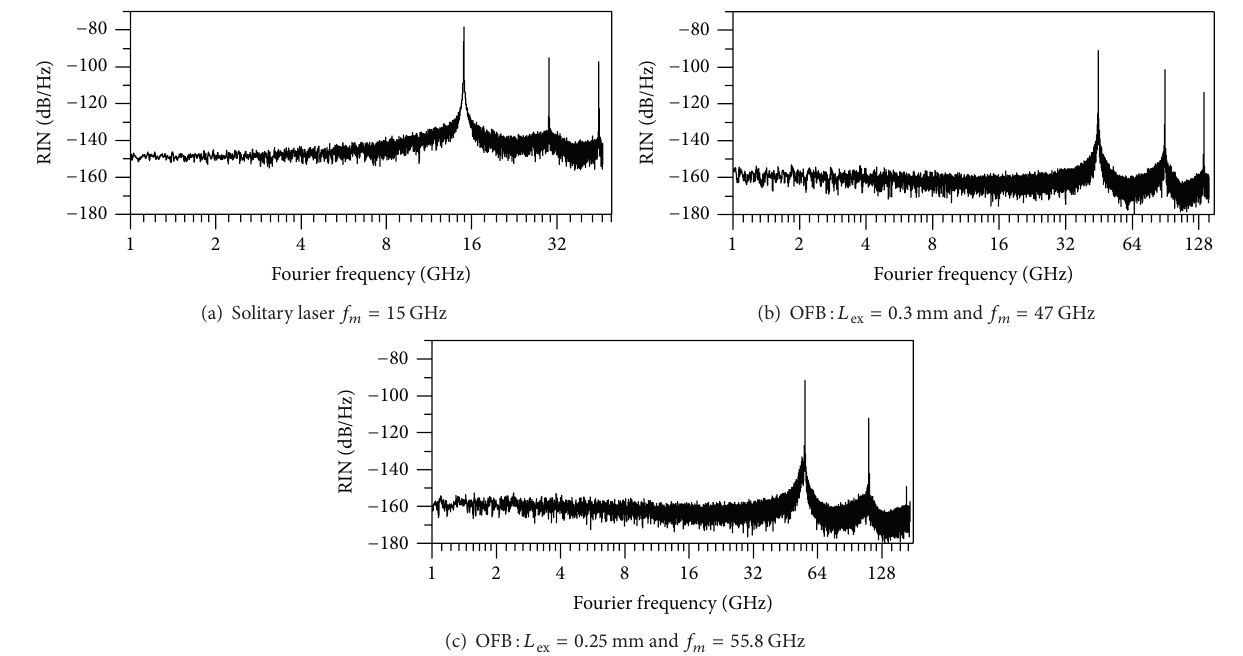
Figure 5: Frequency spectra of RIN of (a) solitary laser modulated at 𝑓 𝑚 = 𝑓 𝑟 , (b) laser under OFB with 𝐿 = 0.25 mm and 𝑓 𝑚 = 55.8 and (c) laser under OFB with 𝐿 ex